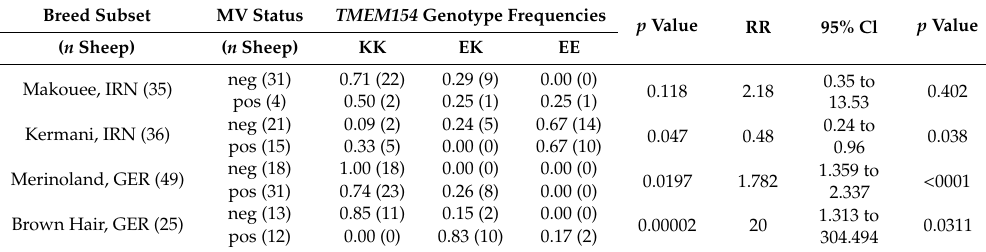
Table 2. TMEM154 E35K genotype frequencies in four SRLV positive sheep breeds of Iran (IRN) and Germany (GER) with results from chi-square / Fisher’s exact test and relative risk (RR) analyses. Breed Subset